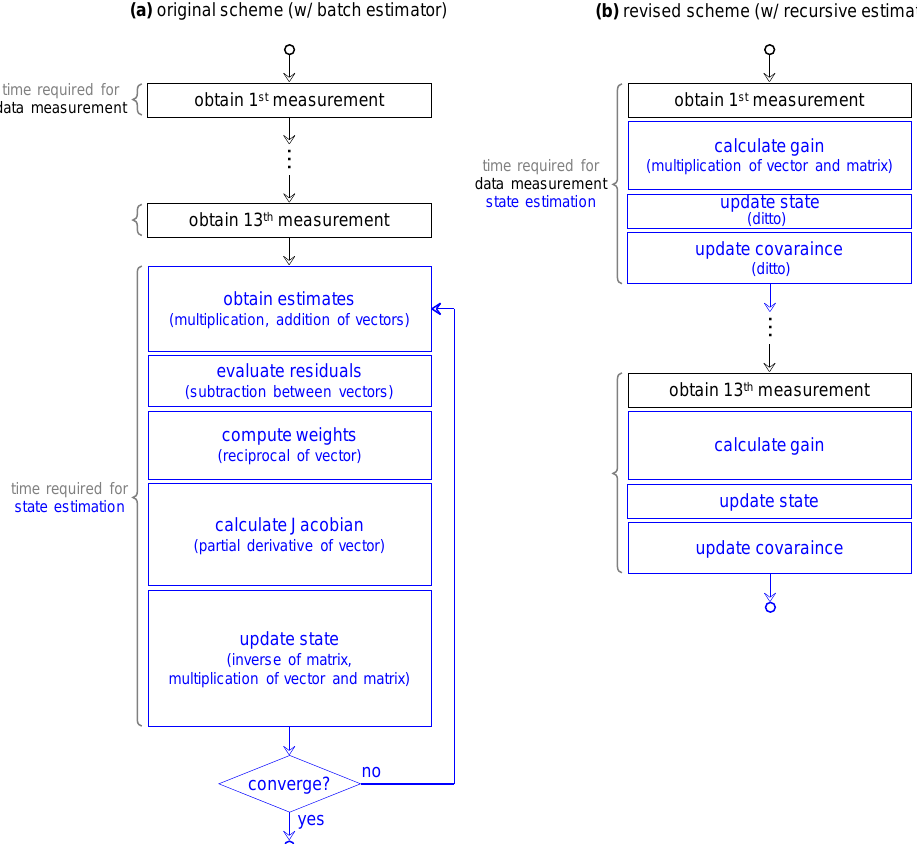
Figure 1. Comparisonof( a )batchestimatorand( b